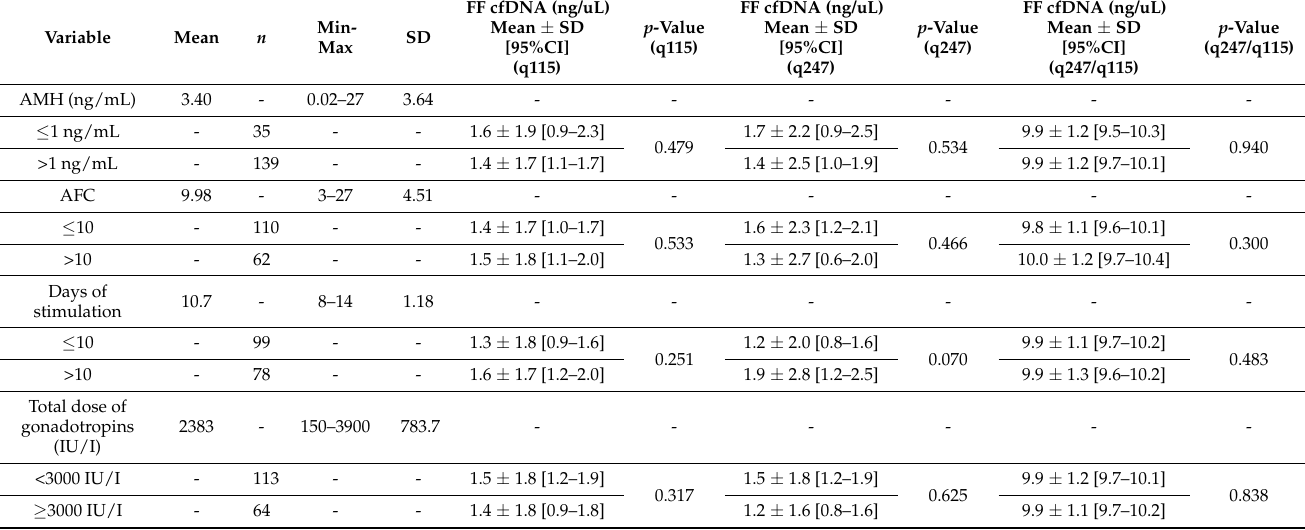
Table 3. Concerning anti-Müllerian hormone (AMH) level, 35 women had low AMH serum concentration at day 3 of the menstrual cycle ( ≤ 1 ng/mL) and 139 had normal AMH (greater than 1 ng/mL). We verified that FF cfDNA concentration did not vary significantly between women with low AMH serum concentration and women with normal AMH. Concerning antral follicle count (AFC), 110 women had low count of AFC ( ≤ 10) and 62 had a normal count of AFC (>10). FF cfDNA concentration was not significantly different between samples of women with low AFC and samples of women with normal AFC. Regarding days of stimulation, 99 women had a long ovarian stimulation (>10 days) and 78 had a short treatment ( ≤ 10 days). We did not find statistically significant differences between long ovarian stimulation and short treatment. Considering the dose of gonadotropins, 113 women received a high total dose of gonadotropins (>3000 IU/I) and 64 women were treated with a lower dose (<3000 IU/I). There was no statistically significant difference between women who received a high total dose of gonadotropins and women stimulated with a lower dose. Table 3. Cell-free DNA levels according to AMH, AFC, days of stimulation and total dose of gonadotropins.